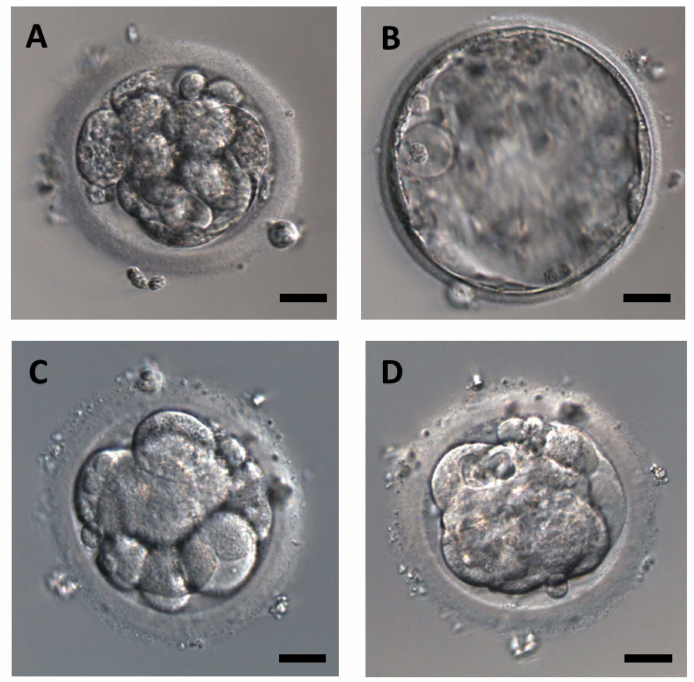
Figure 1. Representative images of human embryos after thawing (0 h, ( A , C )) and after 24 h of cultivation (24 h, ( B , D )) in progressive development ( A , B ) and arrested development ( C , D ). Scale bar represents 20 µ